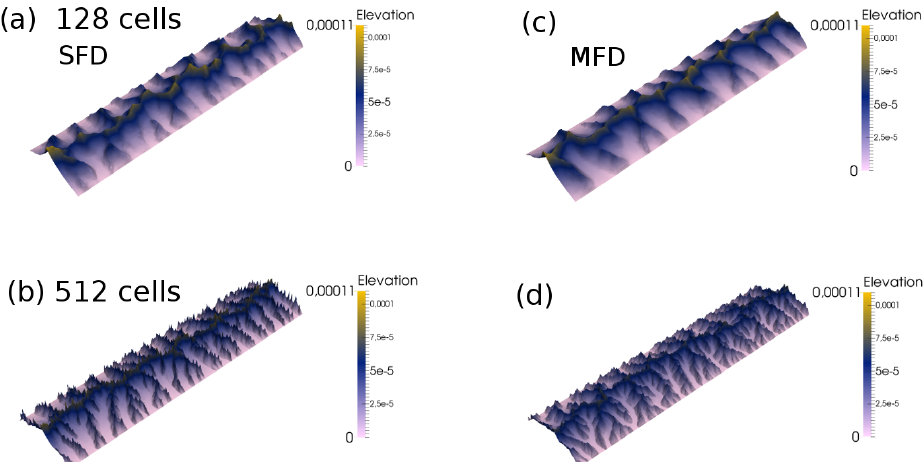
Figure 3. Dimensionless elevation from the cell-to-cell flow routing landscape evolution model with different flow routing algorithms at different numerical resolutions after a dimensionless runtime of 1 . 563 × 10 − 6 (5Myr), with an aspect ratio of 4 × 1. (a) Cell-to-cell single flow direction (SFD) algorithm with a resolution of 512 × 128 cells. (b) The same model but with a resolution of 2048 × 512 cells. Panels (c) and (d) : cell-to-cell multiple flow direction (MFD) algorithm.